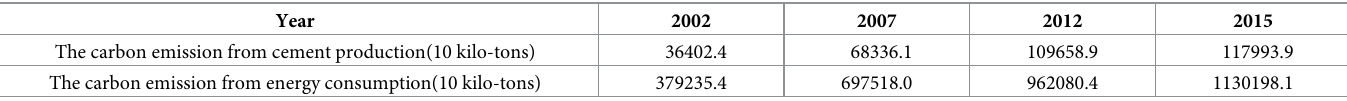
Table 7. The carbon emission from cement production and energy